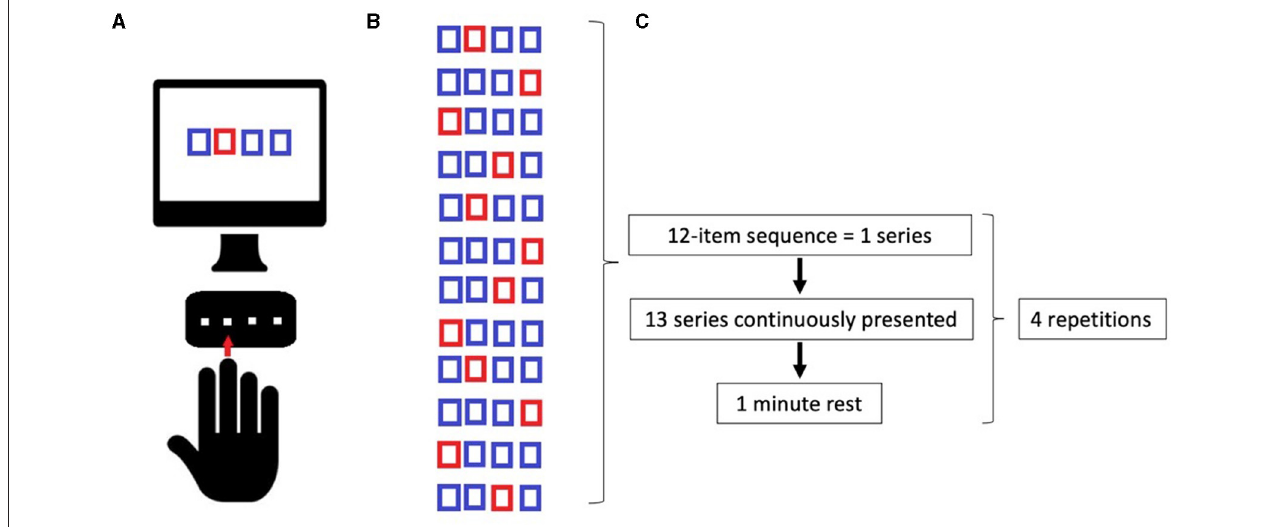
FIGURE 2 | (A) Implementation of Serial Reaction Time Task (SRTT); (B) Learning sequence; (C) Timeline of tasks. See the text.